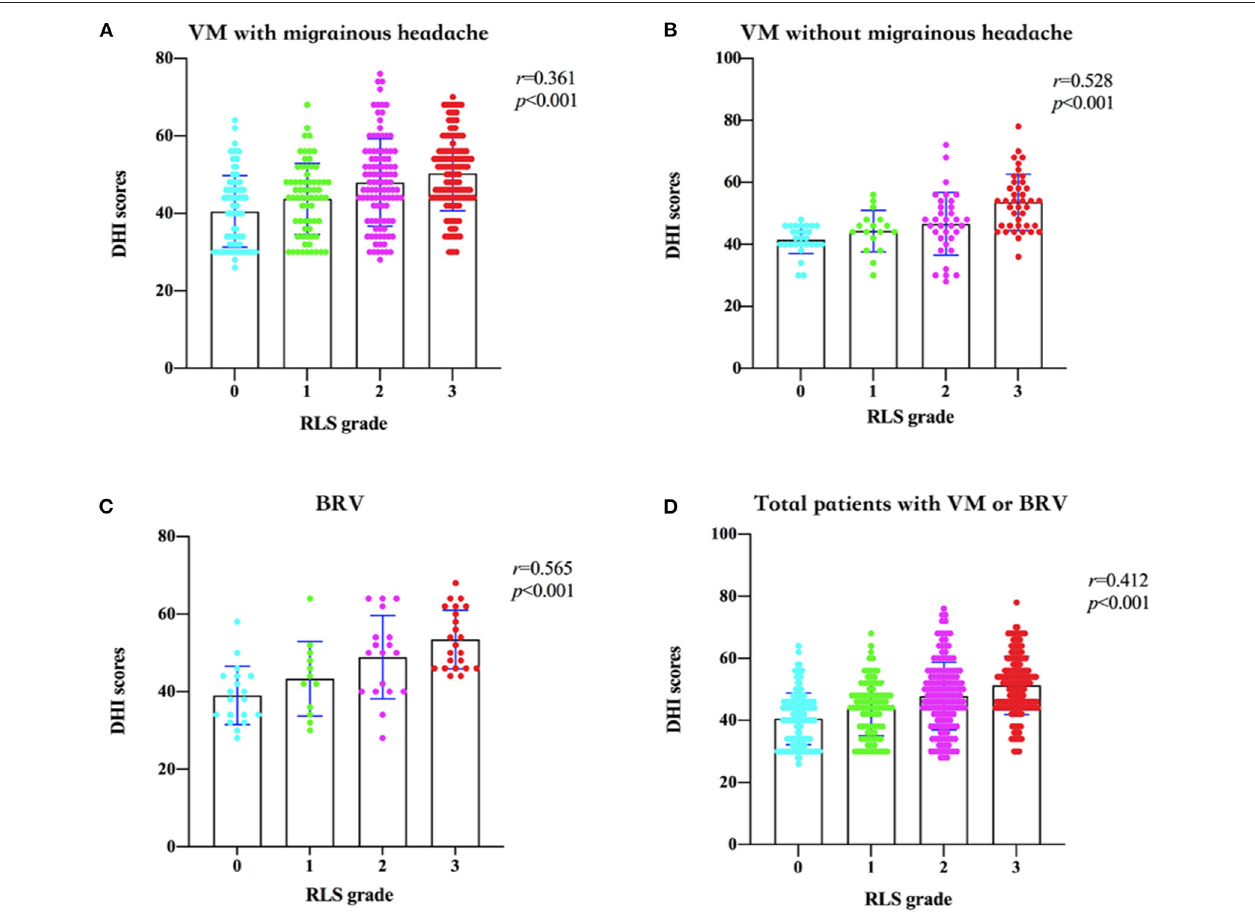
FIGURE 3 | Dizziness Handicap Inventory (DHI) scores and the right-to-left shunt (RLS) grades in patients with vestibular migraine (VM) and benign recurrent vertigo (BRV). (A) In patients with VM with migrainous headaches, the DHI scores increase with increasing RLS grades, and there is a positive correlation between them. (B) In patients with VM without migrainous headaches, the DHI scores increase with increasing RLS grades, and there is a positive correlation between them. (C) In patients with BRV, the DHI scores increase with increasing RLS grades, and there is a positive correlation between them. (D) In all patients with VM or BRV, the DHI scores increase with increasing RLS grades, and there is a positive correlation between them. DHI, Dizziness Handicap Inventory; RLS, right-to-left shunt; VM, vestibular migraine; BRV, benign recurrent